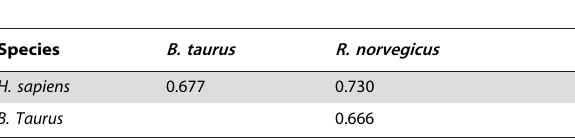
Table 5. Similarity of the slowest modes in